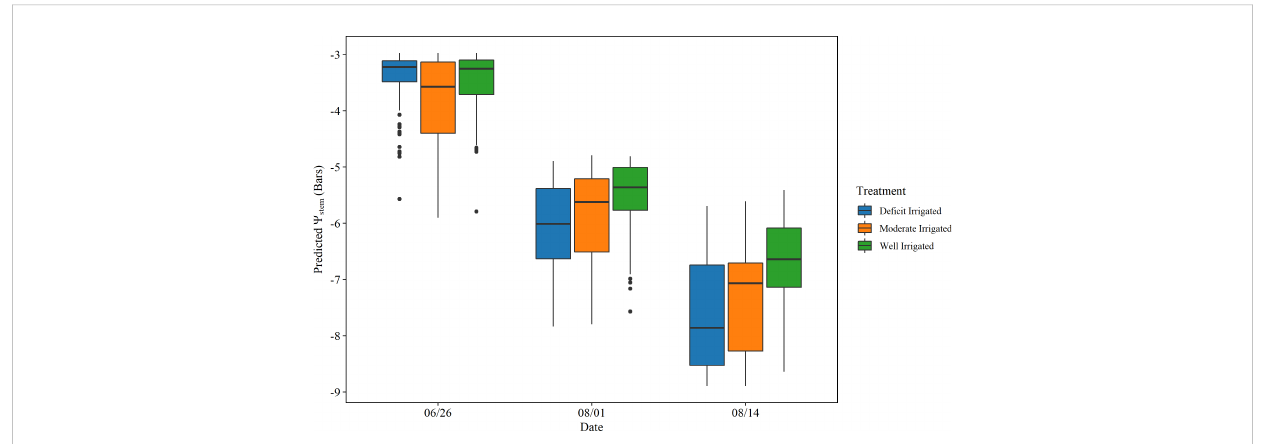
FIGURE 13 Statistics of the predicted stem water potential ( y stem ) from unmanned aerial vehicle-based random forest model summarized over plants with different treatments. Each boxplot shows the minimum, fi rst quartile, medium, third quartile, and maximum values y